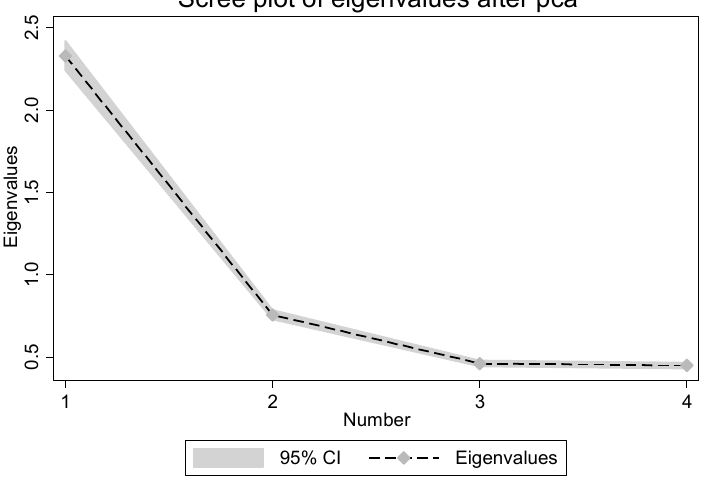
Scree plot of eigenvalues after pca